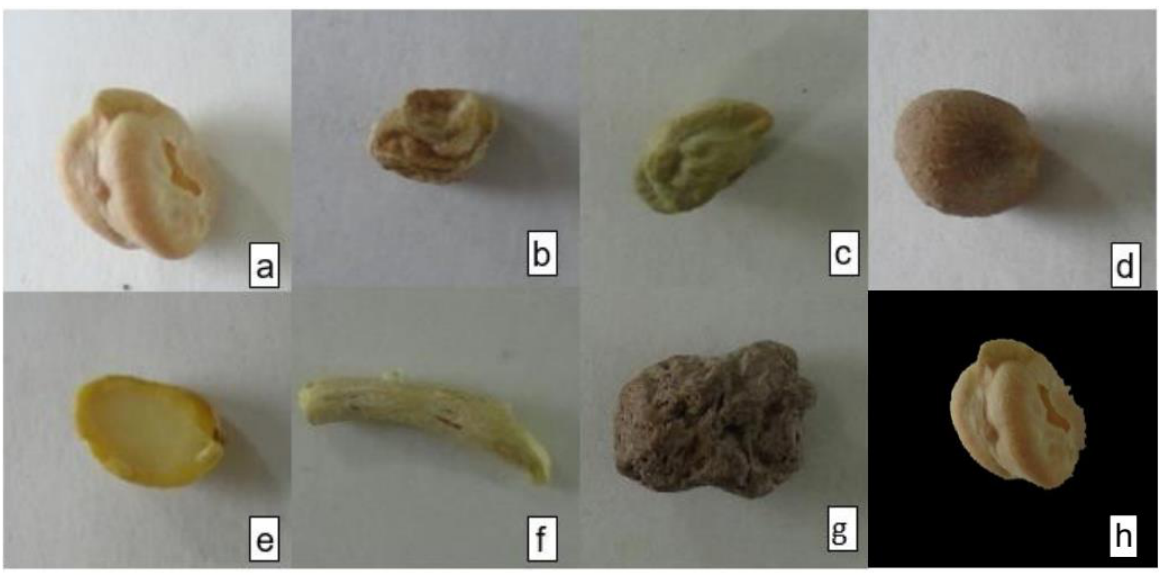
Figure 1. Chickpea, dockage, and foreign materials: sound chickpea kernel ( a ), wrinkled chickpea kernel ( b ), immature chickpea kernel ( c ), brown chickpea kernel ( d ), split chickpea ( e ), stalk ( f ), stone ( g ), and sound chickpea kernel after background separation ( h ).